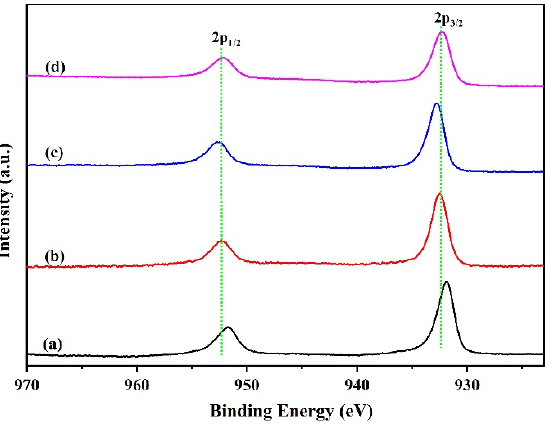
Figure 5. Cu2p XPS spectra of the reduced catalysts. ( a ) CZA, ( b ) CZAGa-1, ( c ) CZAGa-2, ( d ) CZAGa-3.